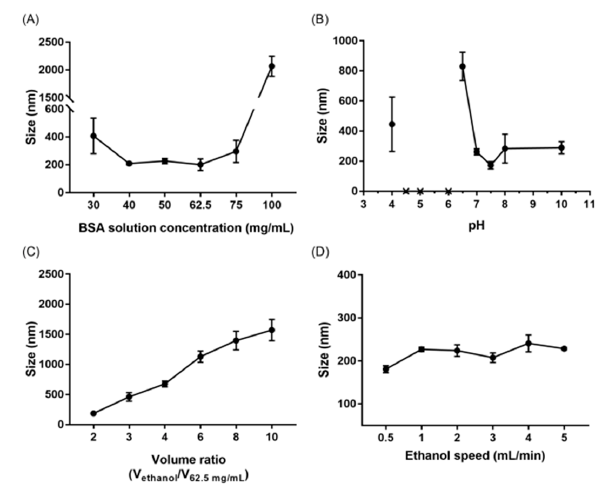
Figure 1. The relationship between bovine serum albumin (BSA) nanoparticles and ( A ) BSA concentrations, ( B ) pH, ( C ) ethanol volume ratio, and ( D ) ethanol addition rate. Note: The crosses in (B) indicate the formulations at pH 6.0, 4.5, and 4.0 precipitated during desolvation. Overall, three different albumin concentrations of 75, 62.5, and 40 mg/mL were selected for sBSANP preparation with a pH ~7 (unadjusted albumin solution), ethanol/albumin solution volume ratio of 2, and an ethanol rate of 0.5 mL/min.